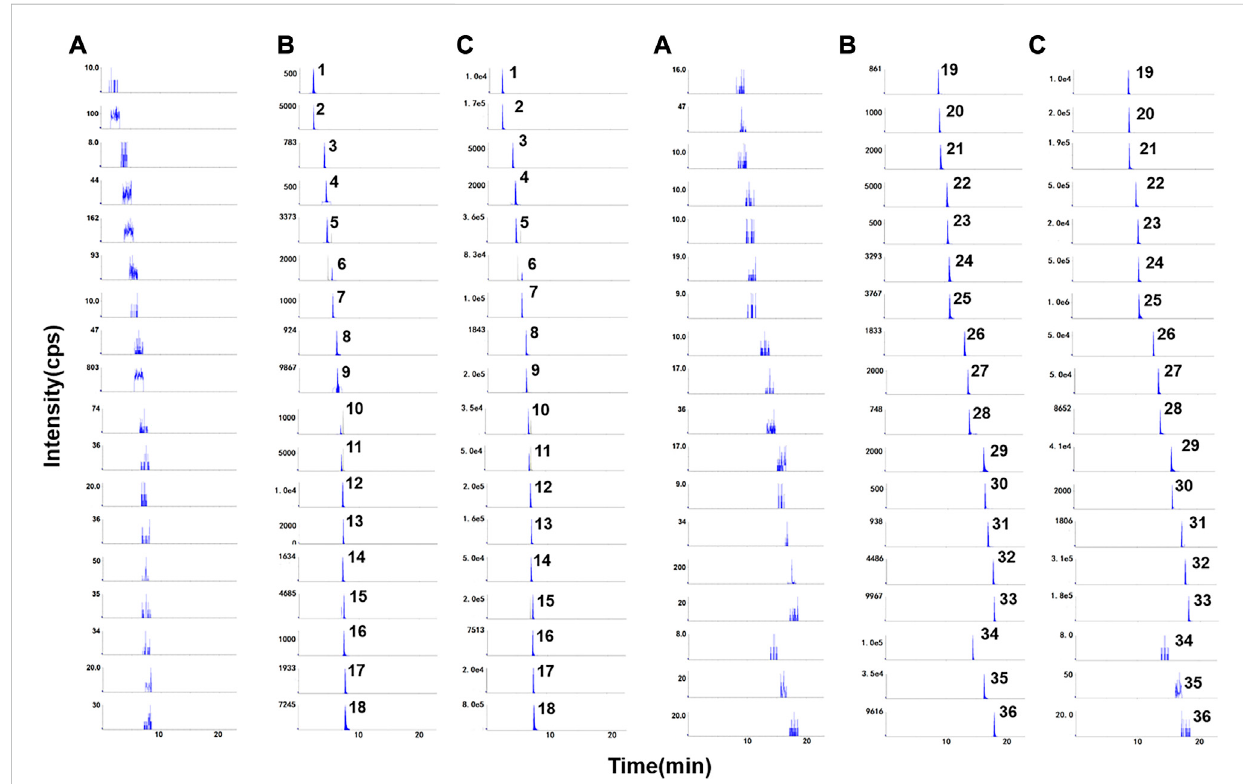
FIGURE 1 Representative chromatograms of (A) blank rat plasma, (B) blank rat plasma spiked with mixed standard compounds at LLOQs and ISs, (C) real samples after administration of QJYQ. 1 – 36 were harpagide, protocatechuic acid, atractyloside A, catechin, chlorogenic acid, cryptochlorogenic acid, verbenalin, paeoni fl orin, p -Coumaric acid, ferulic acid, sinapic acid, vitexin, liquiritin, liquiritin apioside, isoferulic acid, hyperoside, cimifugin, scutellarin, quercitrin, hesperidin, apigenin-7- O -glucuronide, isoliquiritin apioside, ononin, baicalin, isoliquiritin, harpagoside, wogonoside, naringenin, baicalein, ginsenoside Rf, ginsenoside Rh1, glycyrrhizic acid, wogonin, icariin (IS), isopimpinellin (IS) and astragaloside II (IS),